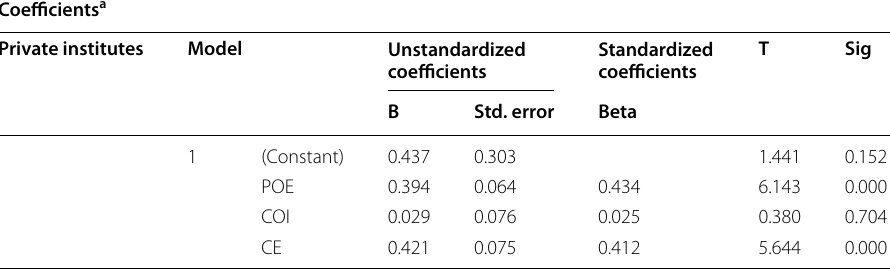
a Dependent Variable: WTC b Predictors: (Constant), CE, Grit Table 14 Coefficients of grit and CE for private institute